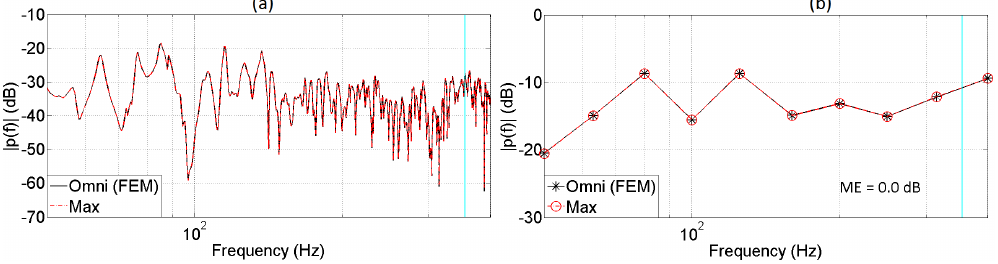
Figure 20. Comparison of full ( a ) and 1/3 octave band ( b ) frequency responses. PWE and omnidirectional room impulse response (FEM) at reference Position 1.